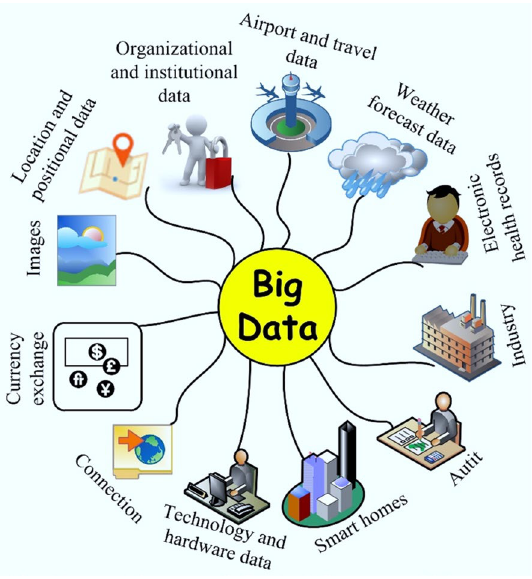
Figure 1. Main steps of the research